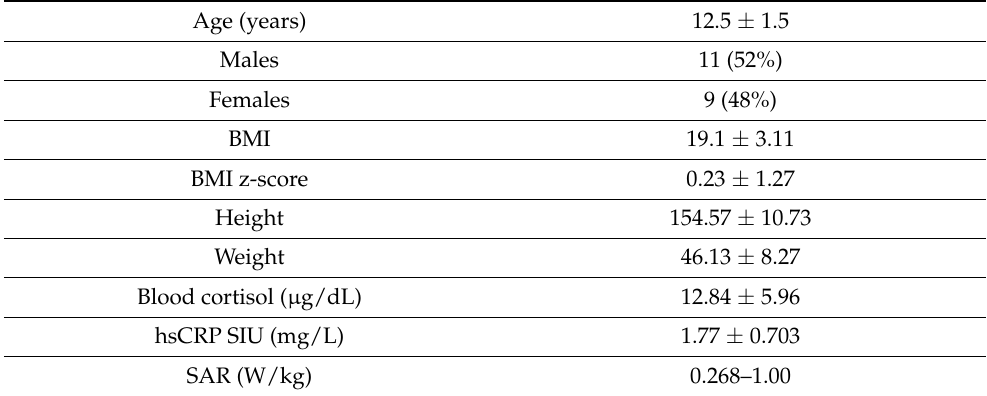
Table 1. Participant characteristics assessed at baseline (mean ± SD).